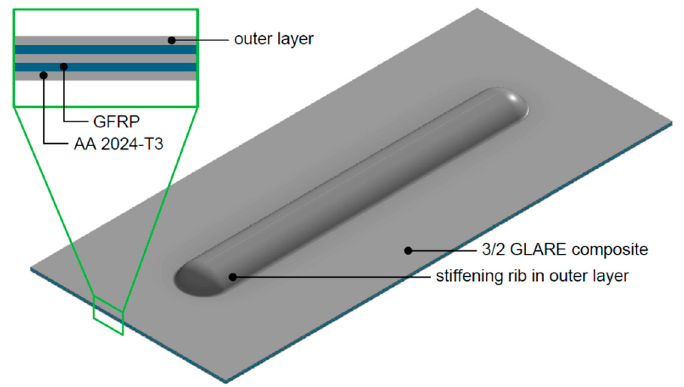
Figure 1. Concept of a glass laminate aluminium-reinforced epoxy (GLARE)-based (3/2 lay-up) structure with a stiffening rib on the outer metallic sheet.